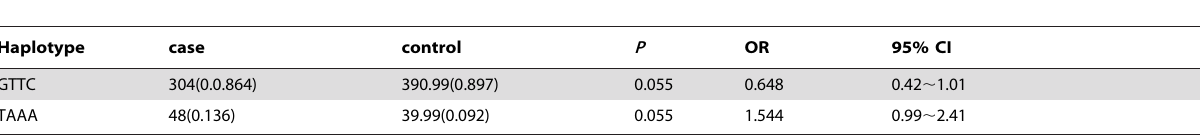
Table 4. Haplotype frequencies of FTO genetic variants in overweight (n=178) and controls (n= 223).